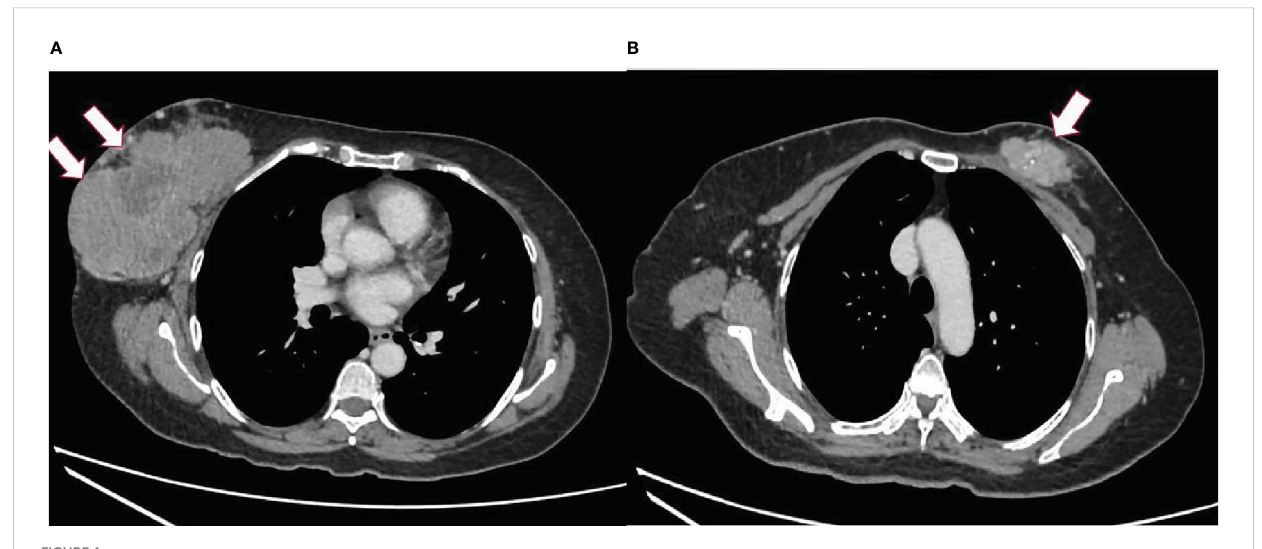
FIGURE 1 CT scan of the thorax. (A) Right breast mass, arrowed. (B) Left breast mass,